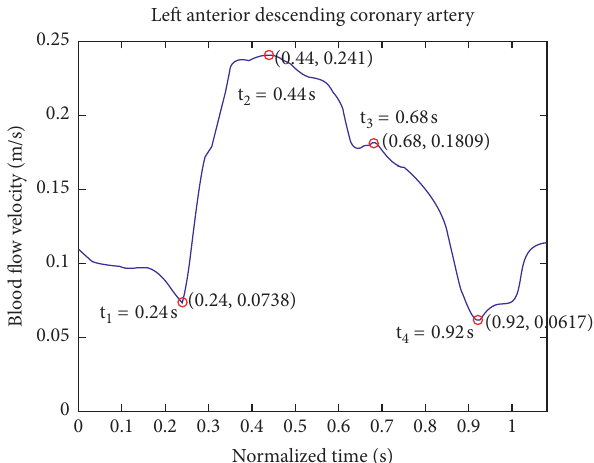
Figure 4: Four typical points during one cardiac cycle. t t 4 are selected from one cardiac cycle and, respectively, represent early systole, peak systole, second peak systole, and end